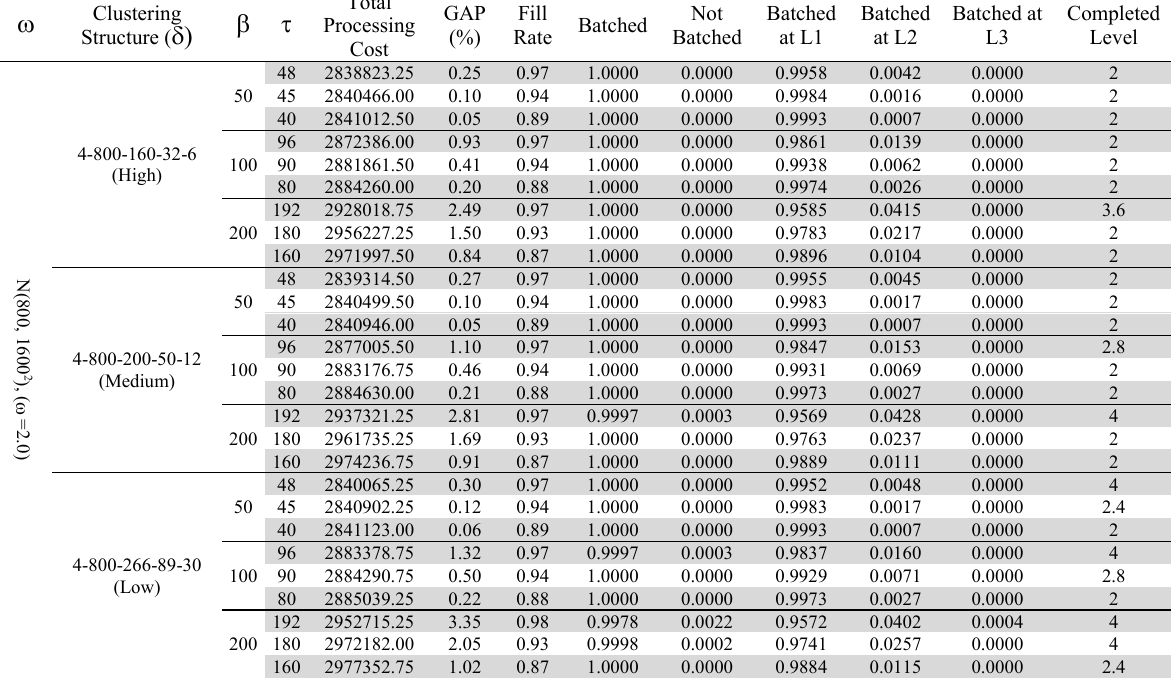
Results for demand scenario S-27 with 4-Level non-exclusive AHCS  Clustering Structure (  )